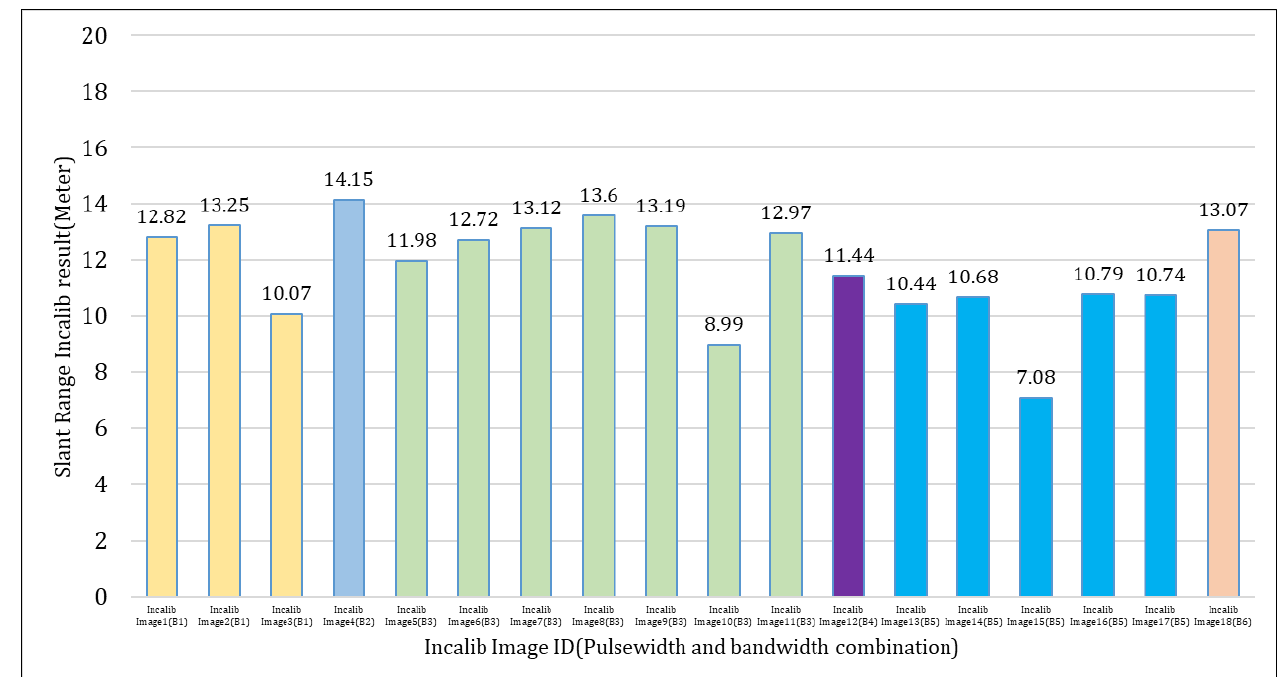
Figure 11. Slant range calibration values of 18 Incalib images.